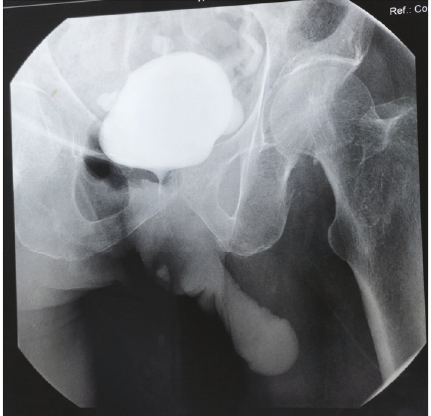
Figure 3: Cystogram performed through suprapubic cystostomy demonstrates obstruction beyond the prostatic urethra.